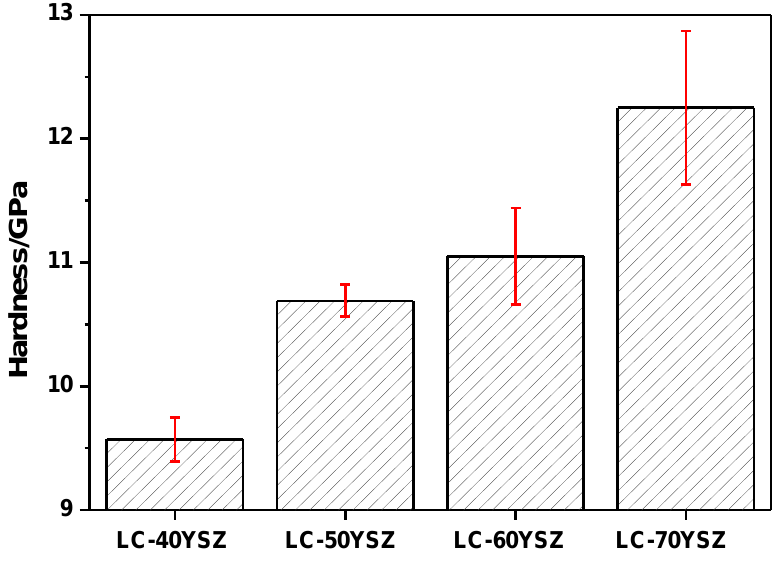
Figure 6. Vickers hardness of LC-YSZ composites.